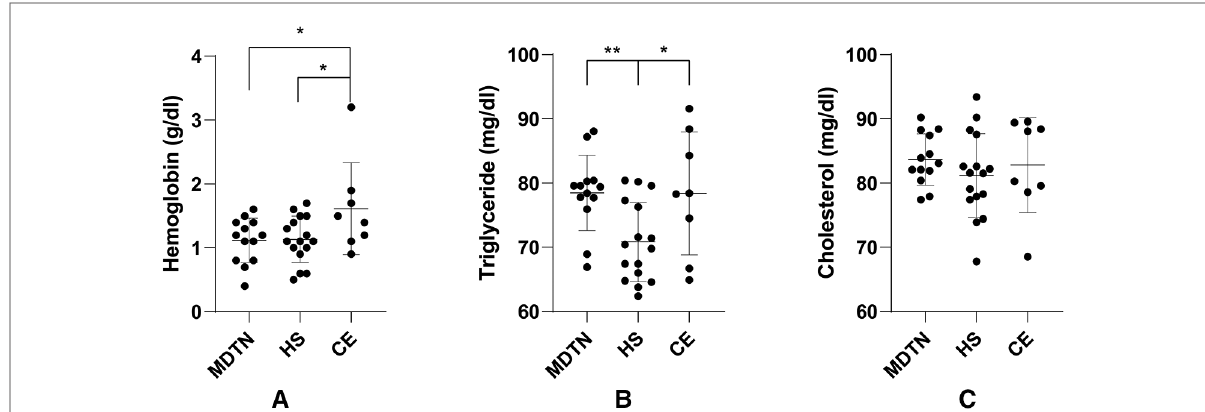
FIGURE 1 Comparison of biochemical indicators in the drainage fl uid from the three groups. ( A ) Hemoglobin concentrations in the drainage fl uid; ( B ) Triglyceride concentrations in the drainage fl uid; ( C ) Cholesterol concentrations in the drainage fl uid. * P <0.05; ** P <0.01.